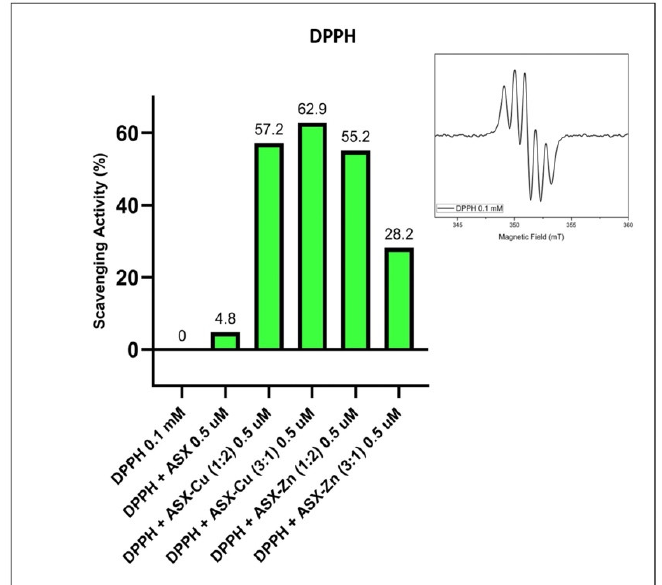
Figure 3. Scavenging activity percentage of ASX and ASX in the presence of metal ion Cu 2+ and Zn 2+ at different molar ratios. In the inset: room temperature EPR spectrum of the DPPH radical. EPR spectra were recorded at room temperature after 30 min of incubation. Experimental conditions: ν = 9.86 GHz, 2.1 mW microwave power and 0.1 mT modulation amplitude.